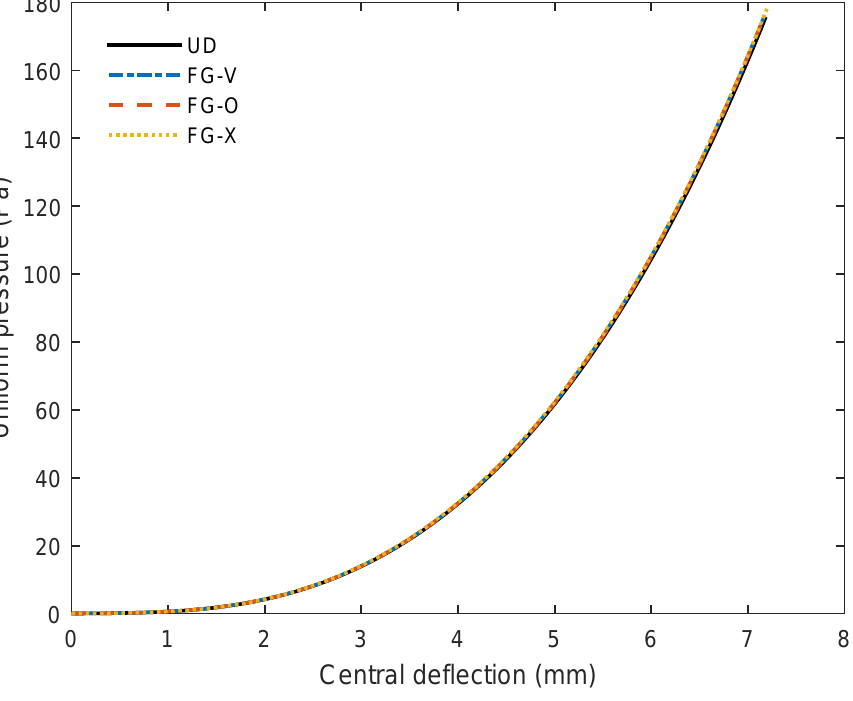
Figure 10. Effect of CNTs distribution on nonlinear response of the fully clamped FG-CNTRC square = 0.11, h = 0.5 mm, κ = membrane with V ∗ CNT